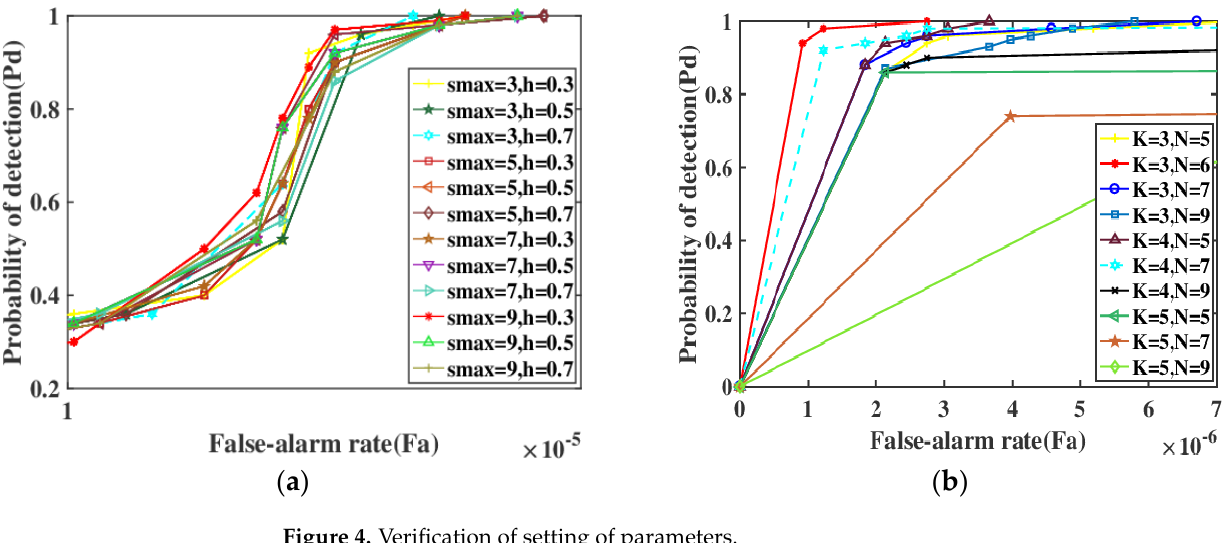
Figure 4. Verification of setting of parameters.